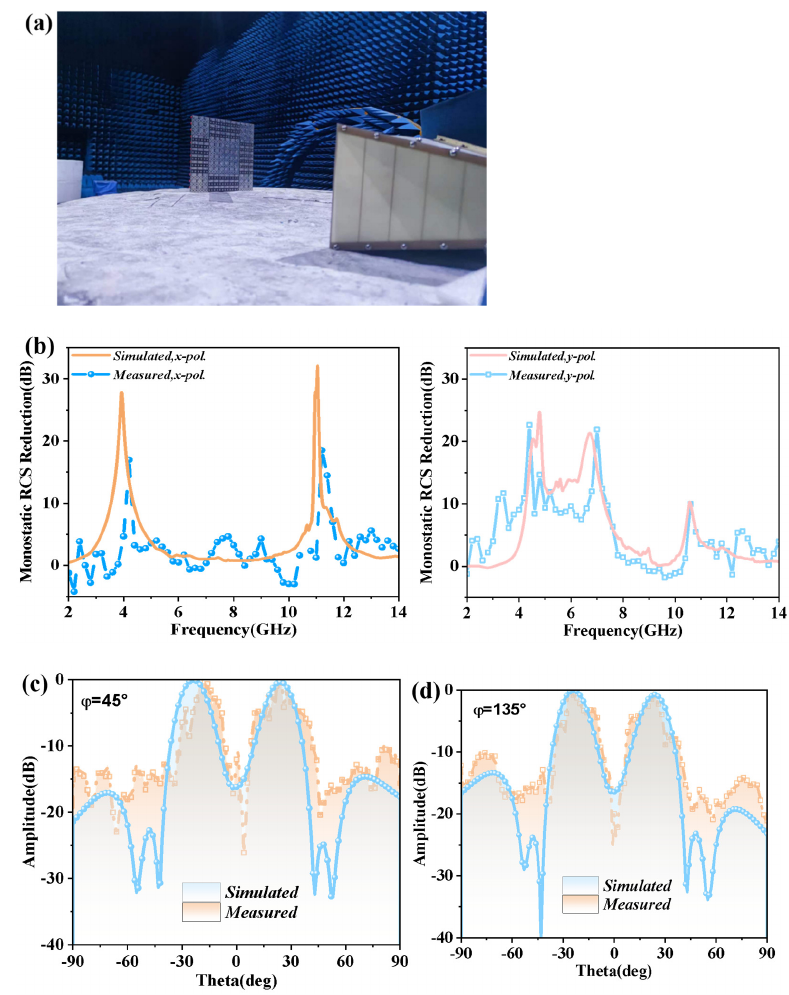
Figure 7. Environment of the measurement and measured scattering results. ( a ) Environment of the measurement for scattering. ( b ) Measured and simulated monostatic RCS reduction with x - or y -polarized incidences. Measured and simulated scattering patterns of ( c ) φ = 45° plane and ( d ) φ = 135° plane for the CFMS with the y-polarized incidence at 4.79 GHz.